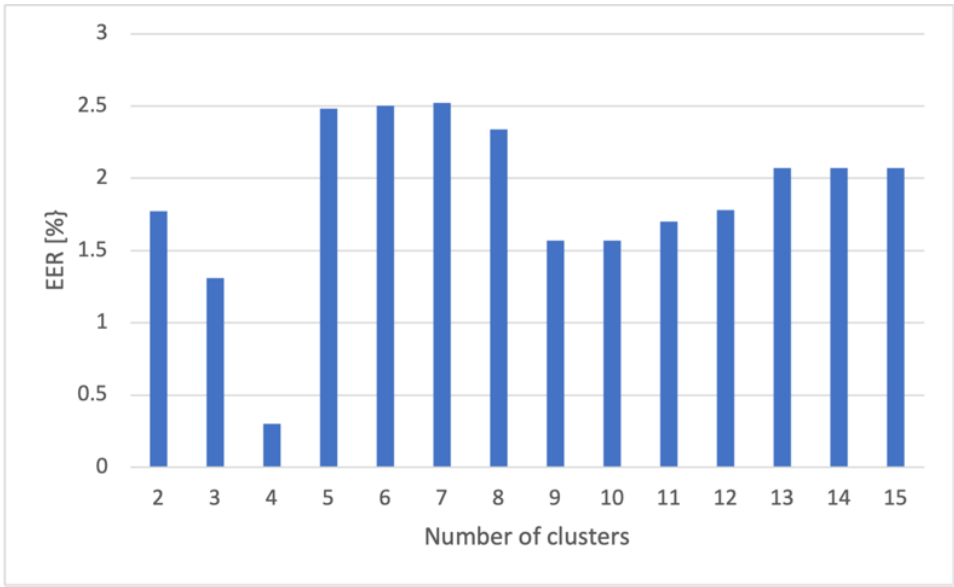
Figure 8. EER with respect to the number of clusters when using SCAD with GMM [6] on CQCC on the ASVspoof 2017 version 2.0 benchmark dataset. Table 9. EER for SCAD with different classifiers on the ASVspoof 2017 version 2.0 Benchmark Dataset. Model